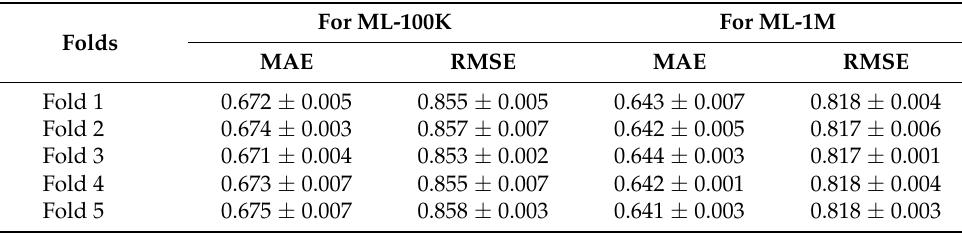
Table 2. Results of the DELCR from five-fold validation for both datasets. The values show the metrics’ average and a 95% confidence interval in a five-fold validation.